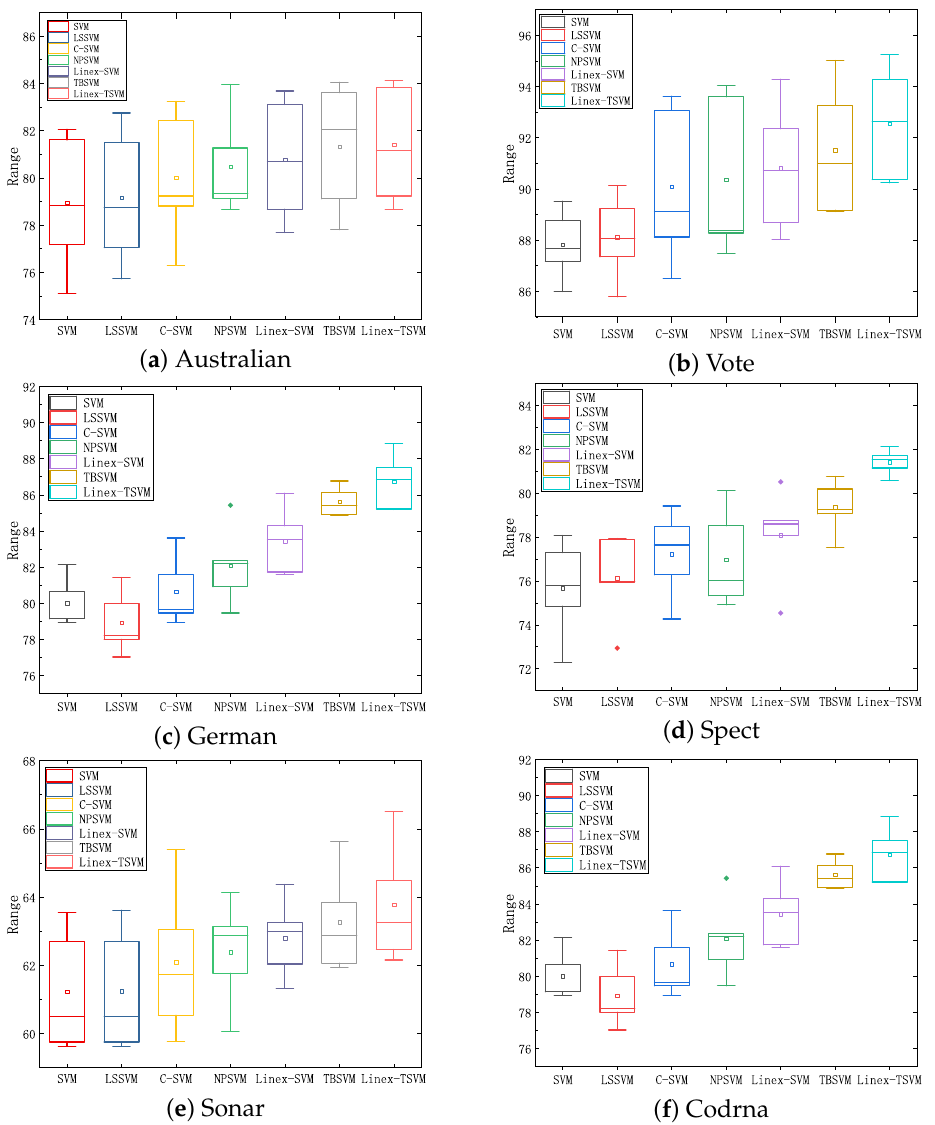
Figure 5. Box diagram of UCI datasets with